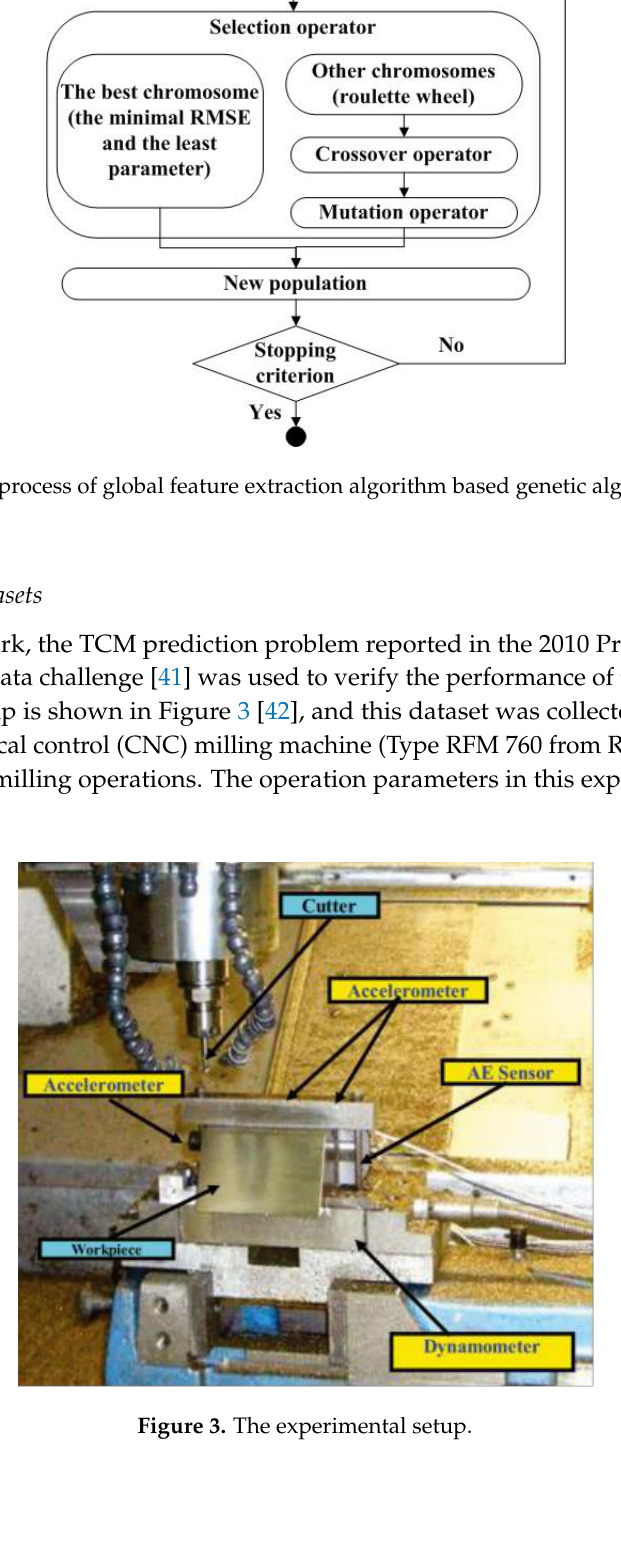
Figure 3. The experimental setup.